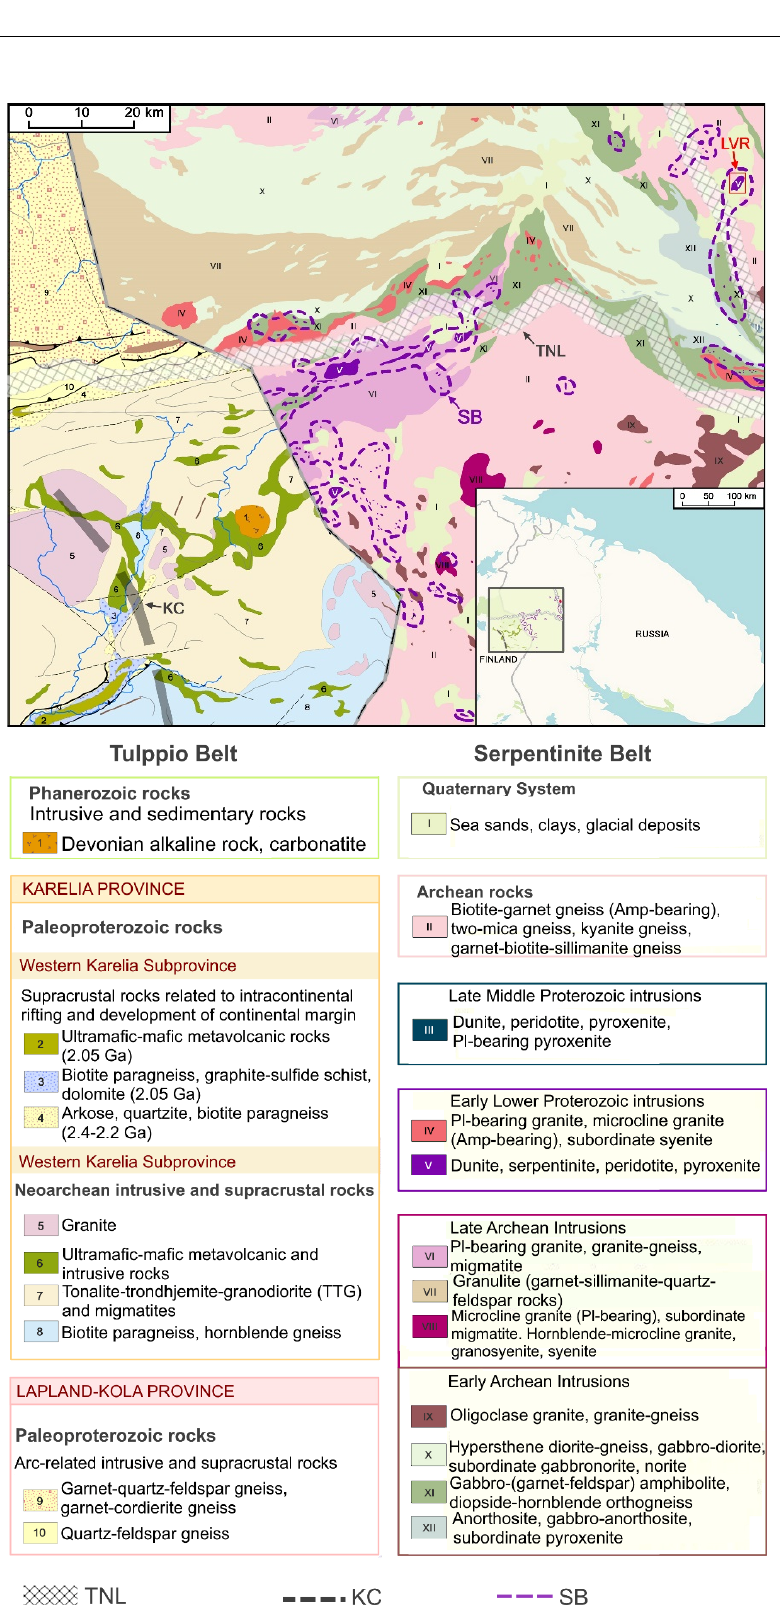
Figure 4. The location and geological setting of the Lyavaraka complex (LVR) relative to other suites of ultrabasic rocks of subvolcanic plutonic complexes of the Serpentinite Belt (SB), all